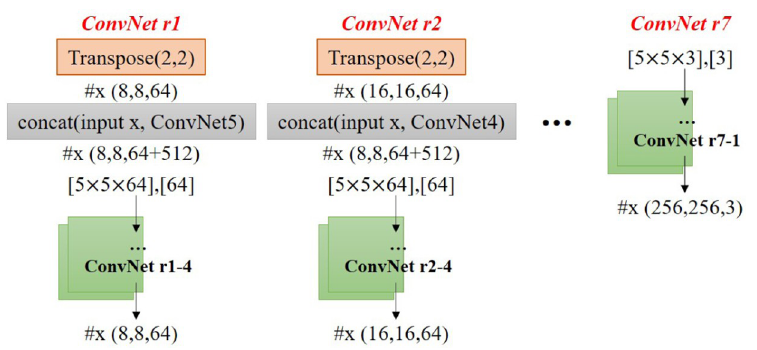
Fig 10. Feature reconstruction (input: x(4, 4, 512), output: x(256, 256, 3)).